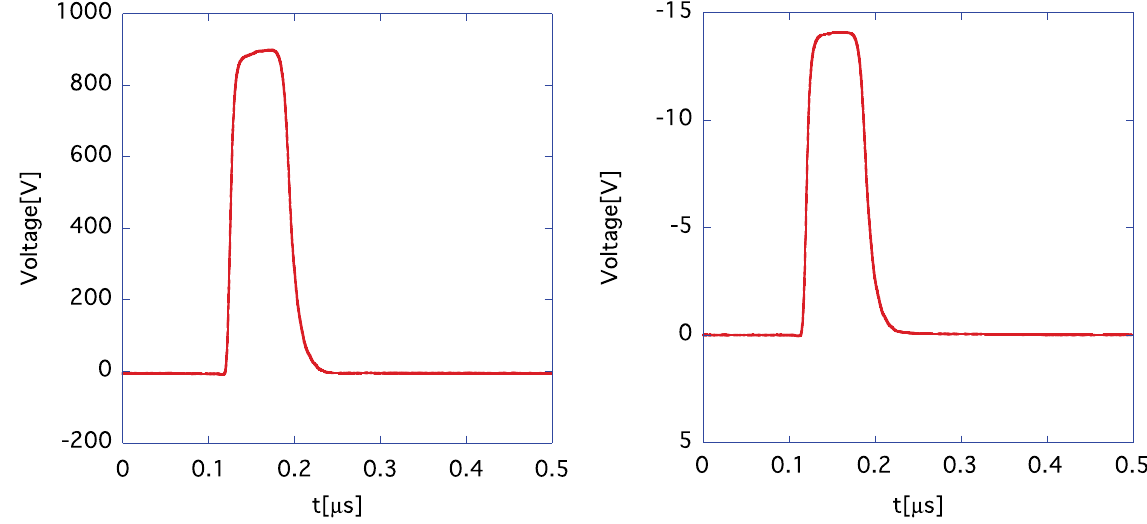
FIG. 10. Current signal at the downstream end of the chamber (left) and the monitored signal on the ceramic break